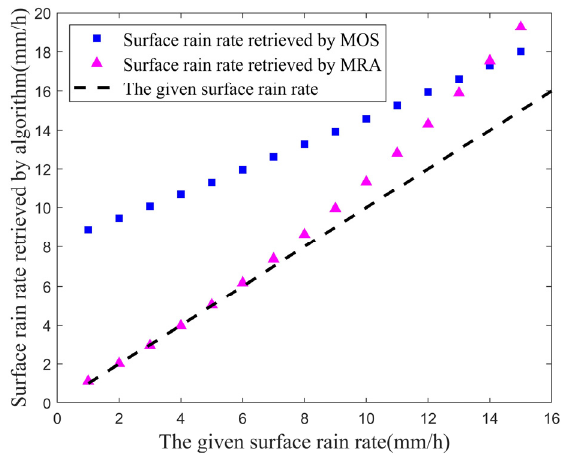
Figure 6. Surface rain rates retrieved by MRA and MOS under rectangular horizontal distribution.